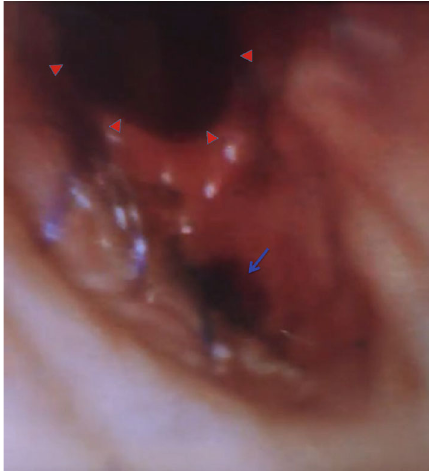
Figure 3: Bronchoscopy showed partial dehiscence of the right mainstem bronchus surgical anastomosis (blue arrow) directly opposite to the right upper lobe ori fi ce (red carets) and distal to sutures.